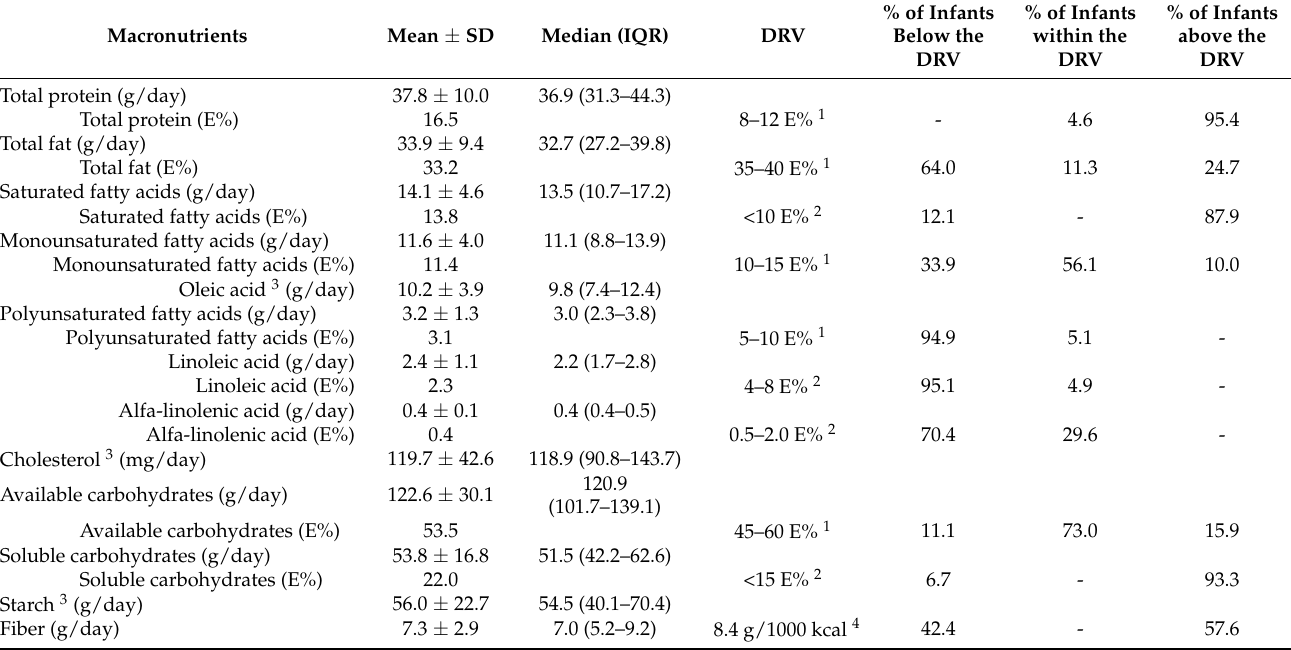
Table 2. Distribution of macronutrients intake in infants at 18 months of age ( n = 389).